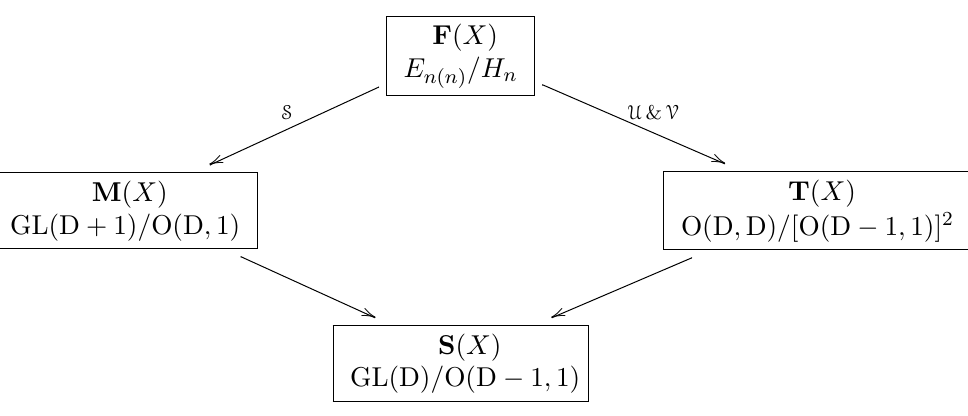
Figure 1 . F-, M-, and T-theories associated to type II string (S-theory) on X . When the dimension of X is D = 3 or 4, there is associated to the D-dimensional type II supergravity S ( X ) on X a (D + 1) -dimensional N = 1 supergravity theory M ( X ) and a D-dimensional, manifestly T-duality invariant supergravity T ( X ) . Each of these results from a theory F ( X ) by solving the S constraint or U and V constraints, respectively